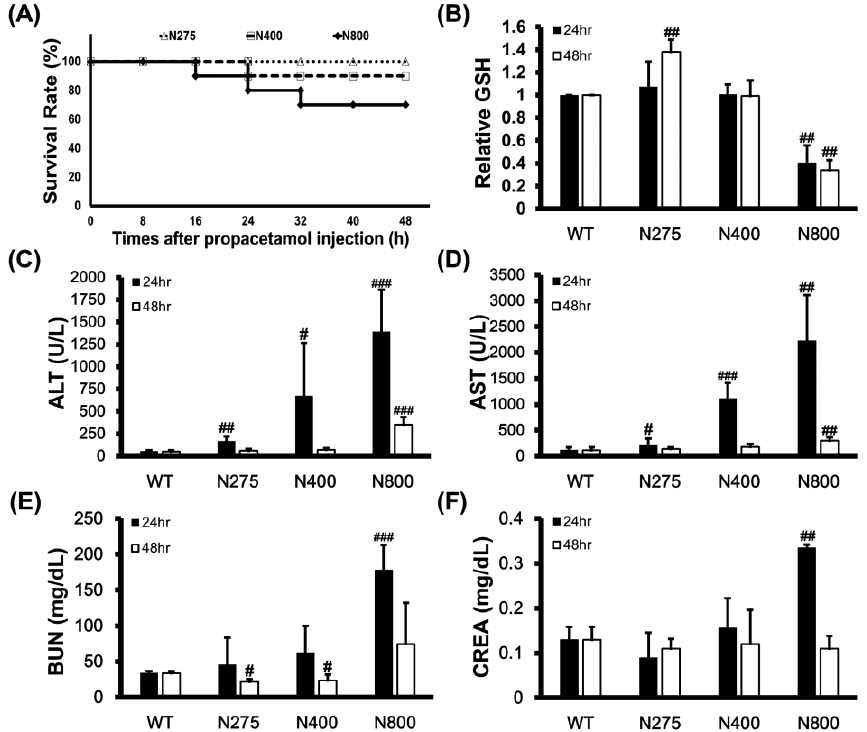
Figure 6. Effects of different doses of NAC on survival rates of BALB/c mice within 48 h ( A ), relative reduced GSH levels in liver ( B ), serum ALT ( C ) and AST ( D ) activities, and blood urea nitrogen (BUN) ( E ) and creatinine (CREA) ( F ) levels at 24 h and 48 h post-NAC injection. The GSH levels in the WT group were defined as 100%. Significant differences compared with the WT group are indicated by # (p < 0.05), ## (p < 0.01), and ### (p <